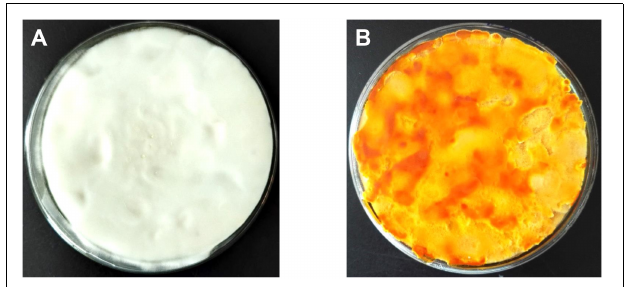
FIGURE 1 | Cordyceps militaris mycelial samples CM10_D (A) and CM10_L (B) .